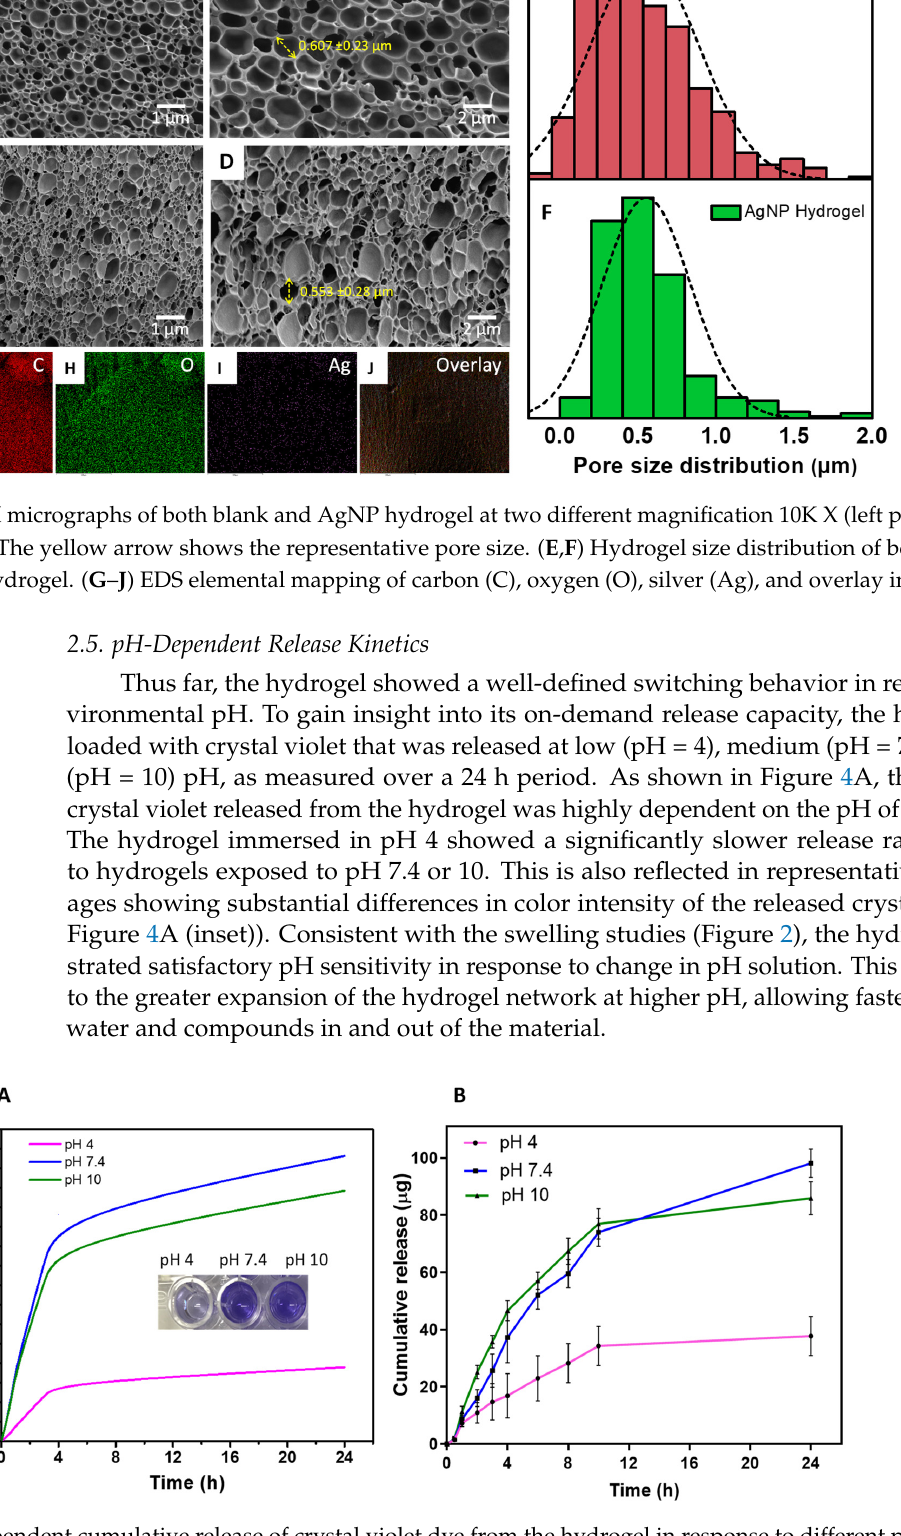
Figure 4. ( A ) pH-dependent cumulative release of crystal violet dye from the hydrogel in response to different pH within 24 h. The inset showing representative digital photographs of crystal violet eluted from the gel. ( B ) Cumulative release of AgNPs from the hydrogel at low, medium, and high pH within 24 h. Data are shown as mean ± SD.